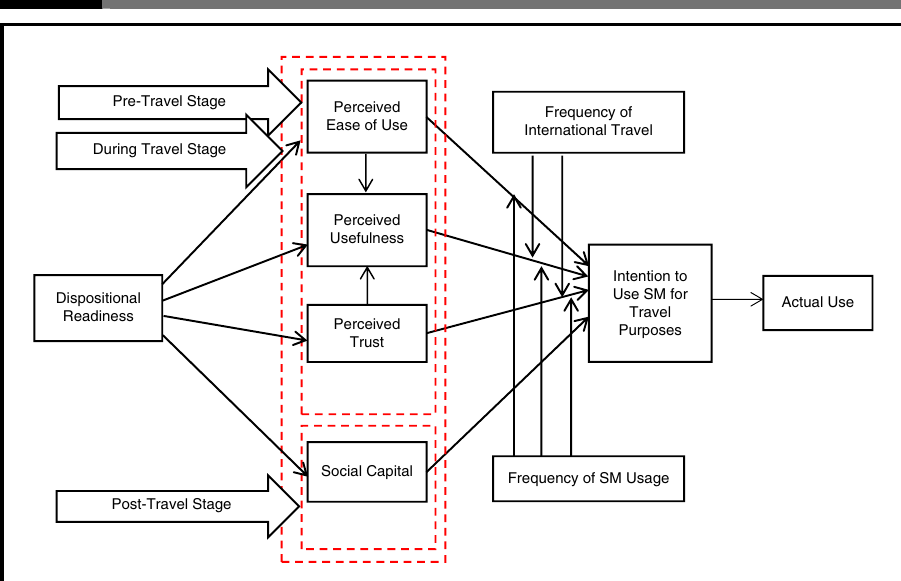
Figure 1 Conceptual model – use of social media for travel